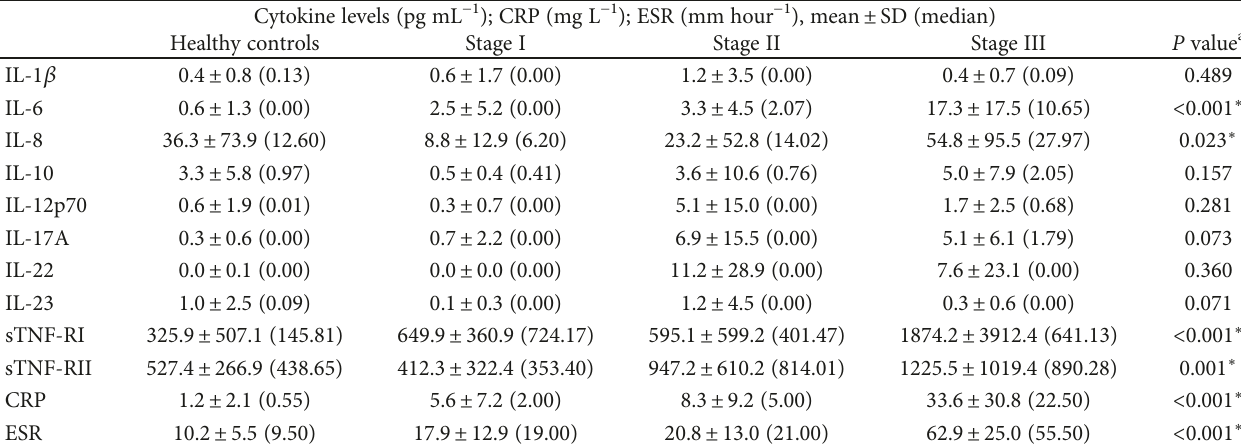
Table 6: Comparison of in fl ammatory serum marker levels among healthy controls and patients with hidradenitis suppurativa according to Hurley staging